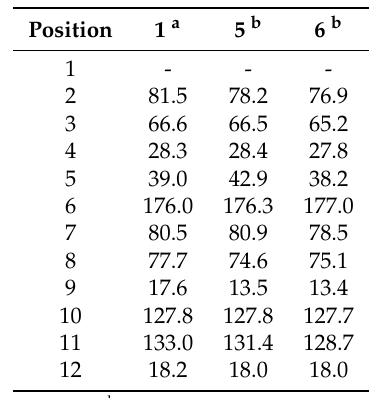
Table 2. Comparison of 13 C-NMR data of 1 with 5 and 6 in CDCl 3